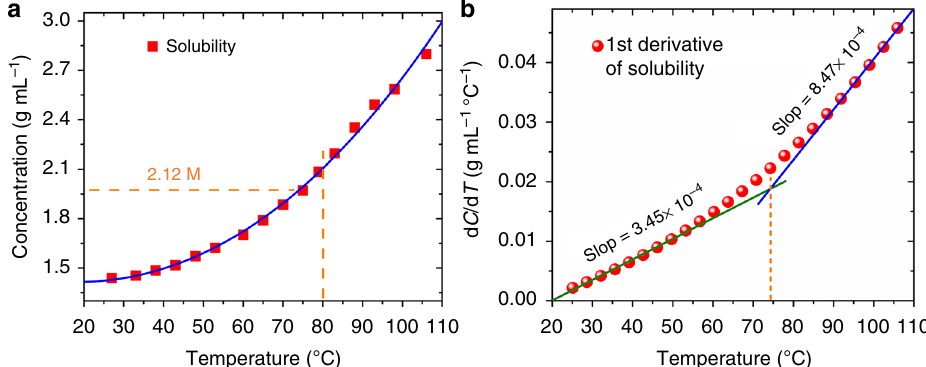
Fig. 1 Temperature-dependent solubility of (PEA) 2 PbI 4 . a Solubility of (PEA) 2 PbI 4 SCM in GBL as a function of temperature. b Solubility derivative with respect to temperature for (PEA) 2 PbI 4 SCM